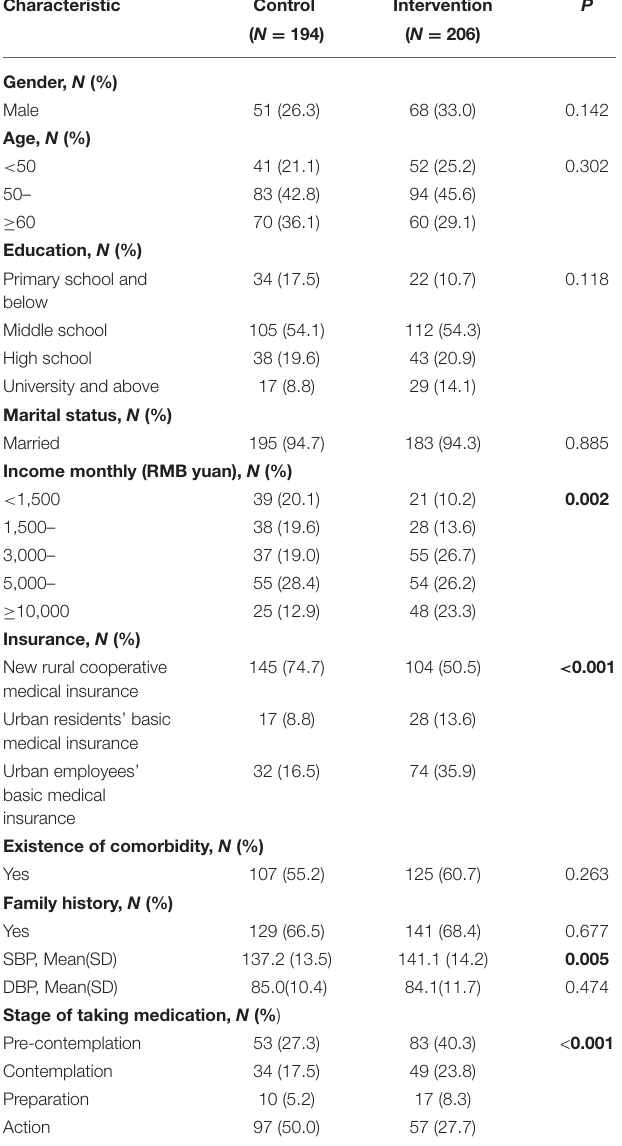
TABLE 2 | Baseline characteristics of participants.